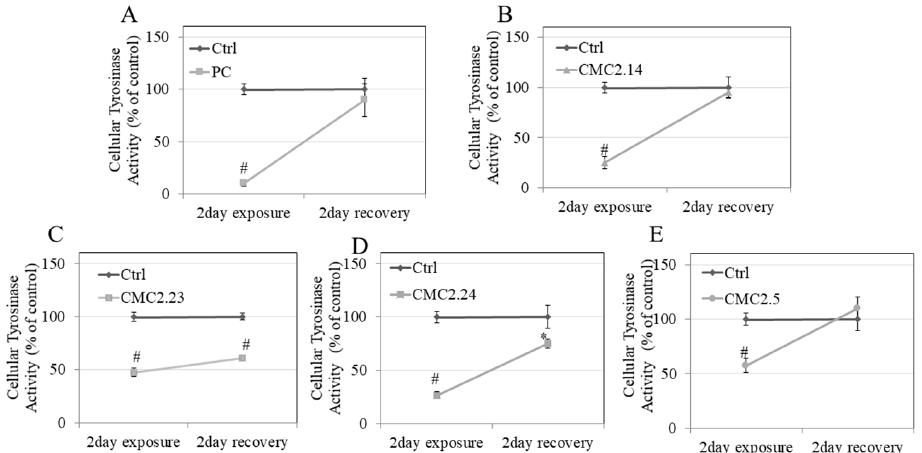
Figure 7. Exposure and recovery study of tyrosinase activity in lysates of B16F10 cells treated with compounds, ( A ) PC (10 µM); ( B ) CMC2.14 (10 µM); ( C ) CMC2.23 (20 µM); ( D ) CMC2.24 (20 µM), and ( E ) CMC2.5 (20 µM); # p < 0.01 vs. control at 2-day exposure; # p < 0.01 vs. control at 2-day exposure; * p < 0.05 vs. control at 2 day recovery; All data are mean ± SD ( n = 3 per group).